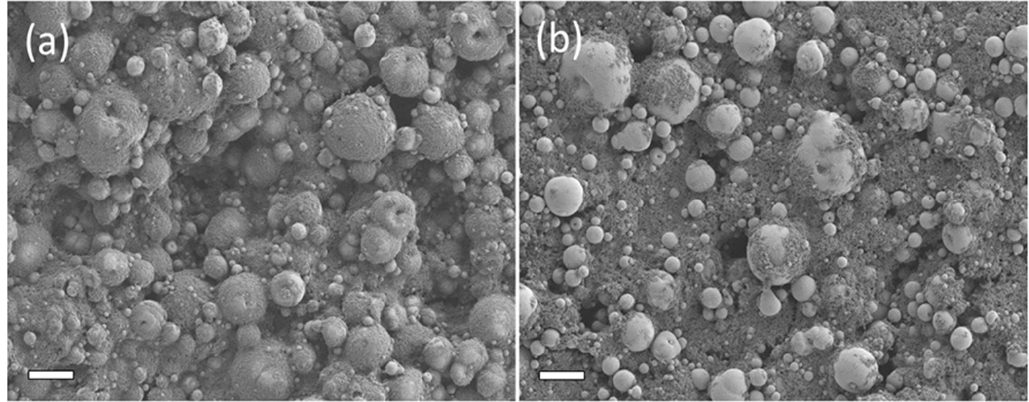
Figure 3. SEM micrographs of prepared cathodes: ( a ) Water-based cathode (scale bar: 20 µm); ( b ) NMP-based cathode (scale bar: 20 µm).